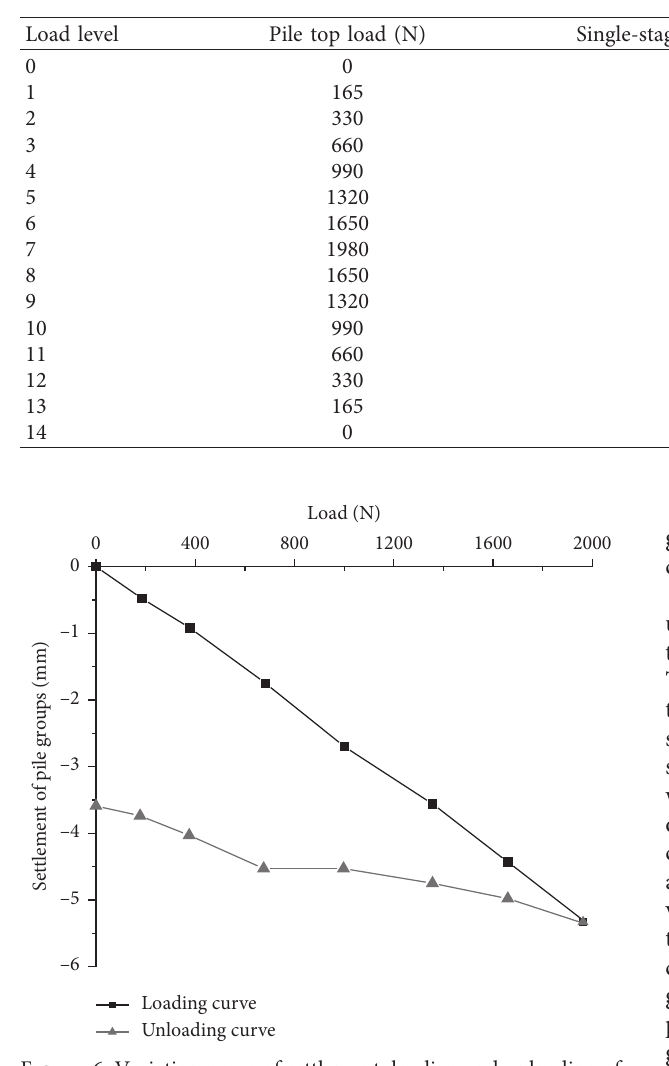
Table 3: Load settlement.